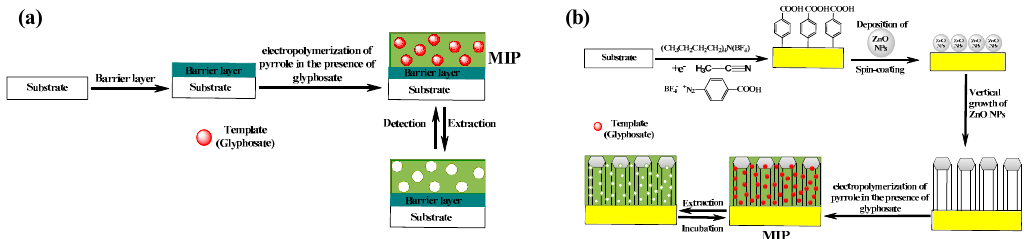
Figure 1. Schematic representation of MIPs preparation ( a ) PPy electropolymerized MIP and ( b ) ZnO- MIP based